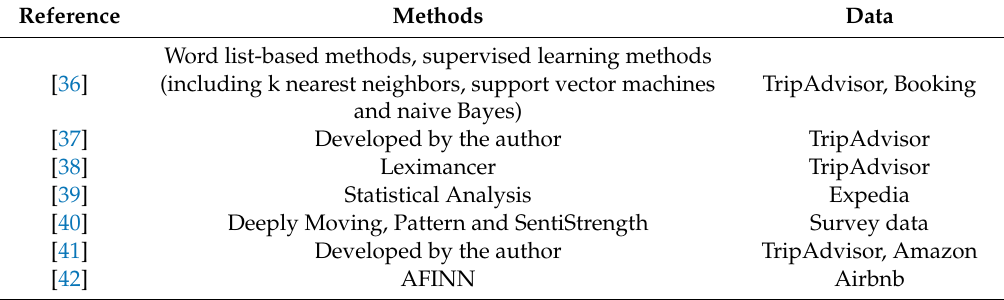
Table 1. The methods of sentiment analysis used in tourism